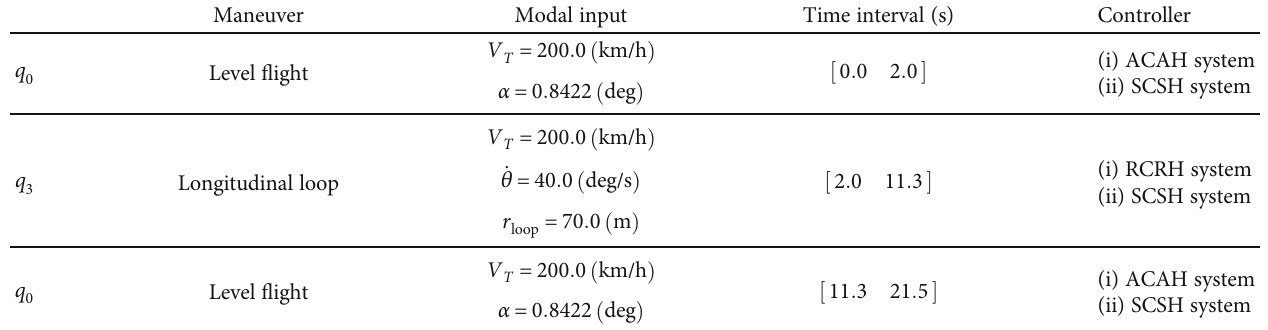
Table 6: Longitudinal loop maneuver.